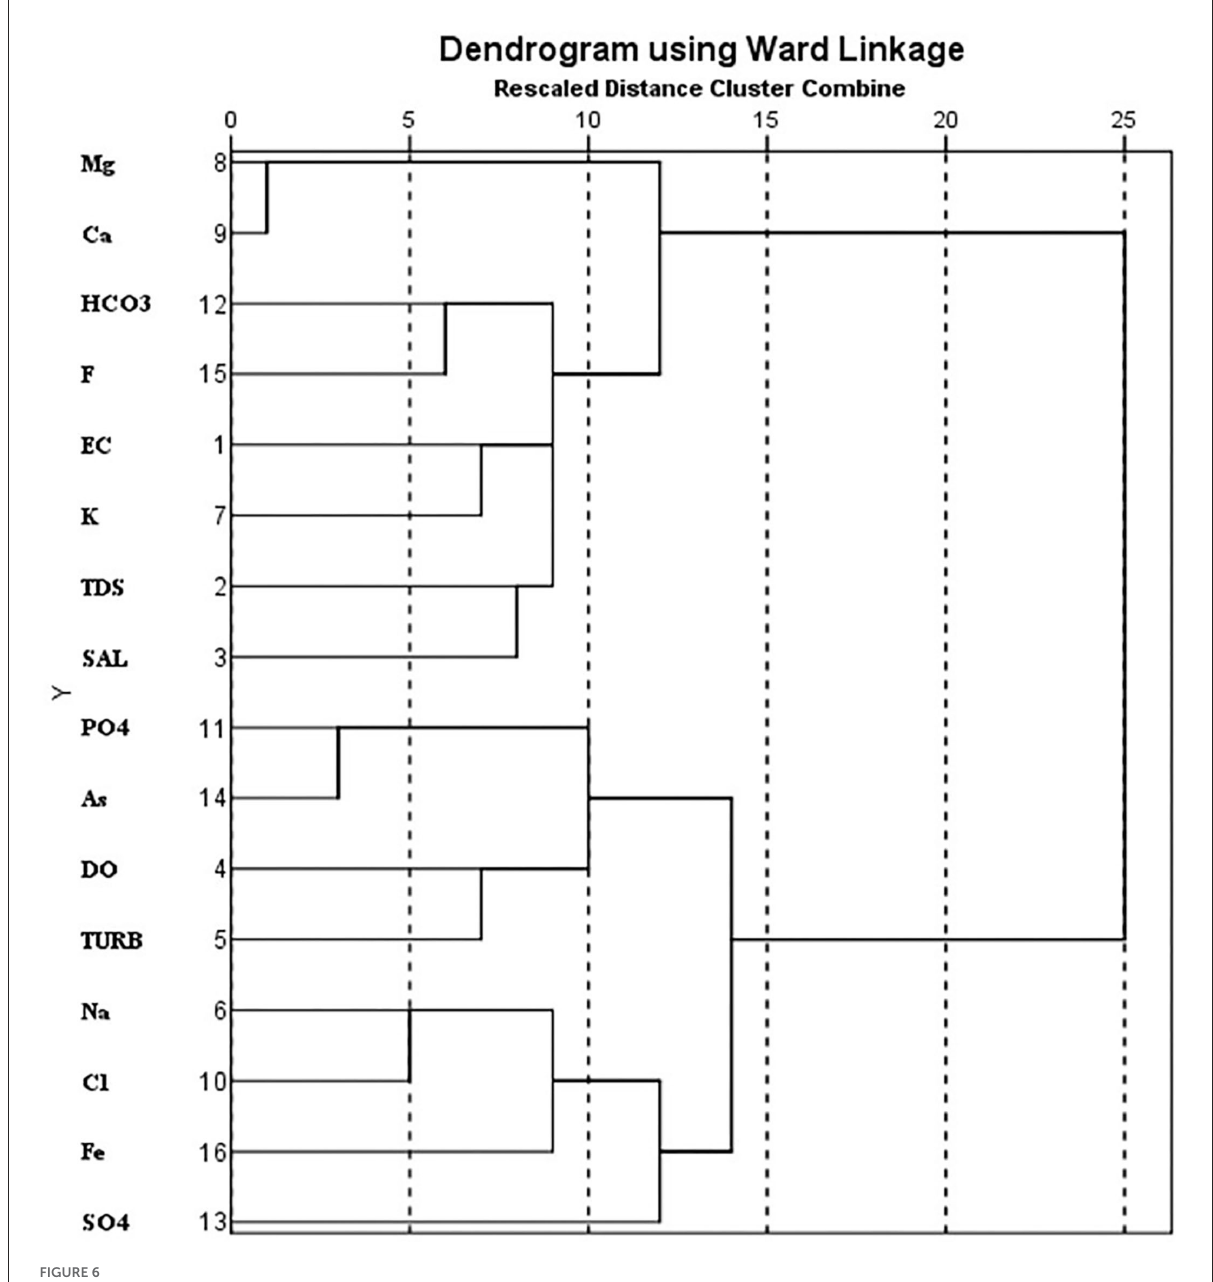
FIGURE6 Cluster analysis of the study